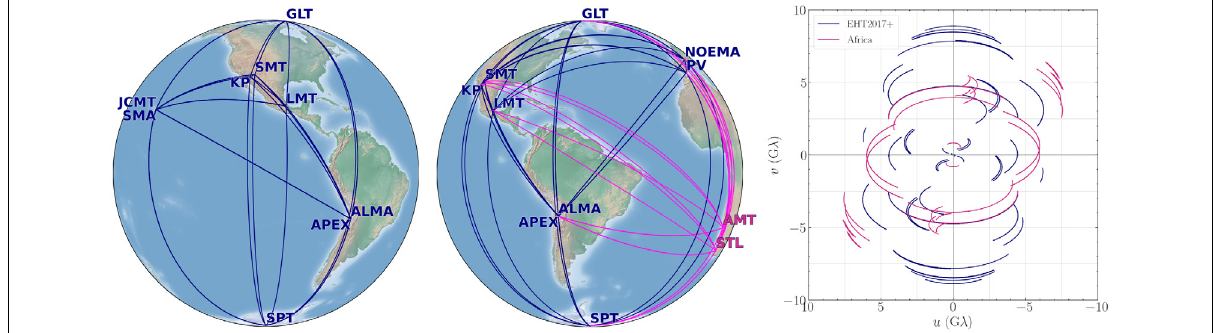
Figure 4: Locations of existing (EHT2017+, blue) and proposed (pink) EHT stations in Africa (left, middle). Baseline coverage of Sgr A* observation during one night in April (right). The ( u , v ) coordinates represent projected baseline vectors for each pair of antennas in units of the observing wavelength. As the earth rotates, an individual baseline will trace out an arc. The blue arcs correspond to the baselines formed by EHT2017+ and the pink arcs correspond to the baselines contributed by the African